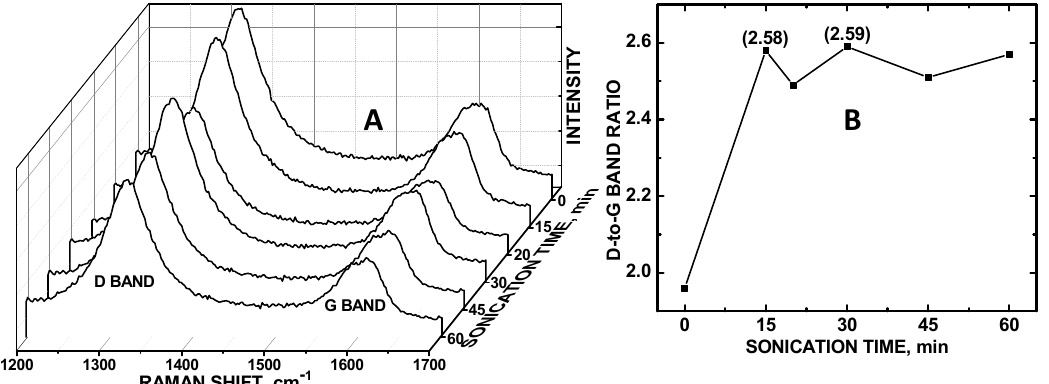
Figure 2. ( A ) Raman spectra of CoO / COOH-MWNT at 0 to 60 min of sonication; ( B ) Plot of Raman D / G band integrated peak area ratio vs sonication time.